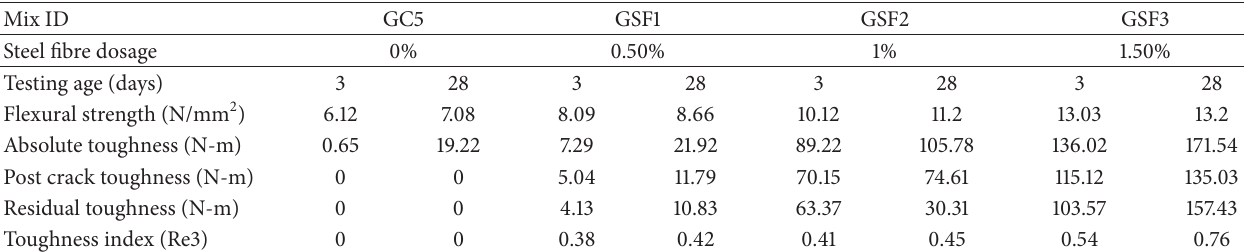
Table 5: Toughness properties of various steel fibre reinforced geopolymer